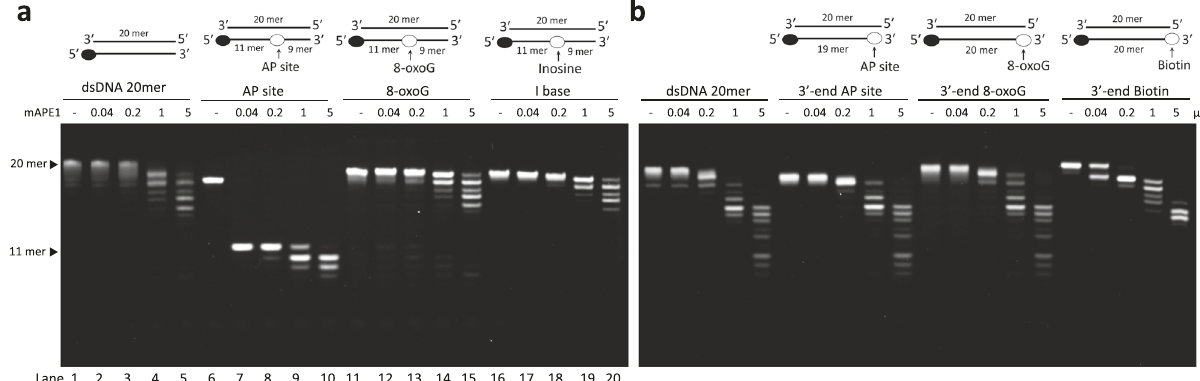
Fig. 2 Base preference of mAPE1 in endo- and exonucleolytic cleavage. a Incubation of mAPE1 with 5 ′ -FAM-labeled dsDNA substrates, including perfectly paired dsDNA (dsDNA 20 mer), dsDNA with an AP site in the middle (AP site), dsDNA with a 8-oxoguanine in the middle (8-oxoG) and dsDNA with a hypoxanthine base in the middle (I base). The endonuclease activity of mAPE1 demonstrates high speci fi city, only AP site containing dsDNA is incised. The NaCl salt concentration for the endonuclease activity assays is 120 mM. b In exonuclease activity assays, mAPE1 is incubated with 5 ′ -FAM- labeled dsDNAs containing different nucleotide modi fi cation or biotin at the 3 ′ -end, including AP site (3 ′ -end AP site), 8-oxoG (3 ′ -end 8-oxoG), and biotin (3 ′ -end biotin). All the dsDNAs with different 3 ′ -end modi fi cations are excised by mAPE1 as the protein concentration is higher than 0.2 μ M. The NaCl salt concentration for the exonuclease activity assays is 30 mM. a , b Source data are provided as a Source Data fi le. Table 1 The exonuclease activity of mAPE1 in processing various dsDNAs. Blunt-ended dsDNA